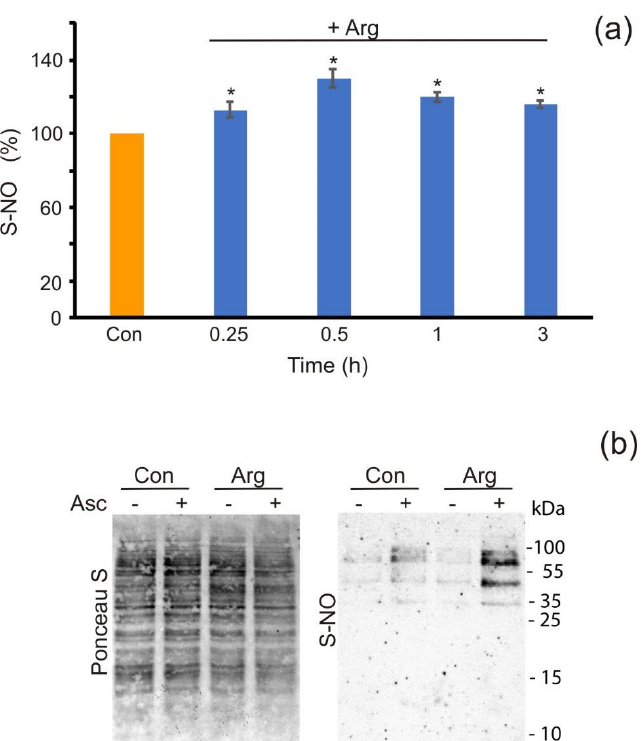
Figure 5. Modification of protein S-nitrosation status by arginine. ( a ) The P. parva samples were treated with 1 mM arginine (pH7.0) for the indicated periods. The quantity of nitrosated ( − SNO) groups in proteins in the cells without added arginine represents the control (Con, set to 100%). Means ± SEs of three biological replicates. * denotes significant differences between the control and test variants according to the Student’s t test ( p value < 0.01). ( b ) The samples used were without added arginine (Con) or treated with 1 mM arginine (pH 7.0) for 0.5 h. The degree of protein S- nitrosation was measured by Western blot with an anti-TMT antibody. Labeling with a non-biological iodoTMT™ reagent was performed with or without 5 mM ascorbate (Asc). Ponceau S staining was used to confirm the equal loading of the different samples.